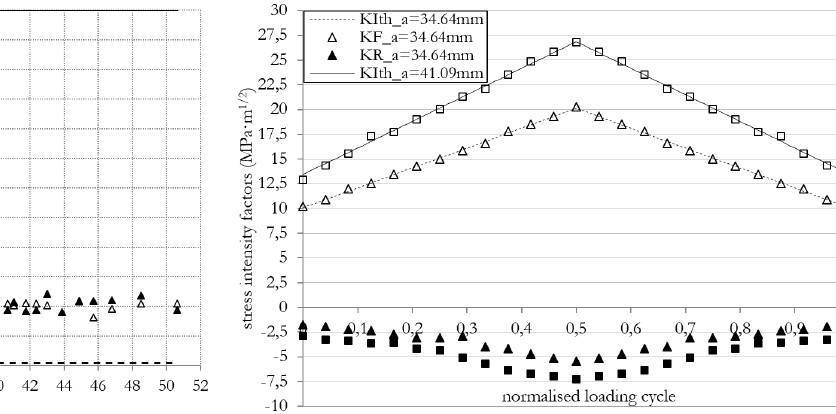
Figure 8: P op and P cl values obtained at different crack lengths for the specimen tested at low R -ratio using the strain offset method.